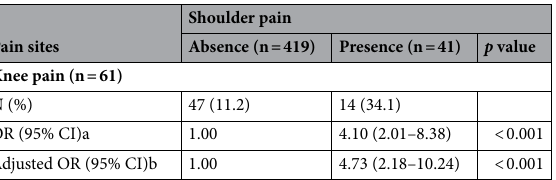
Table 2. Association between knee pain and shoulder pain among elementary school age badminton players. OR odds ratio, CI confidence intervals. a Crude model. b Adjusted for gender (male or female), age (7–8, 9–10 or 11–12 years), BMI (body mass index), badminton experience (< 1, 1 to < 3 or ≥ 3 years), h per day (≤ 2.5, or > 2.5 h), days per week (≤ 3, 4–5, or 6–7 days), total h per week (≤ 11, or > 11 h), warming up (yes or no) and cool down (yes or